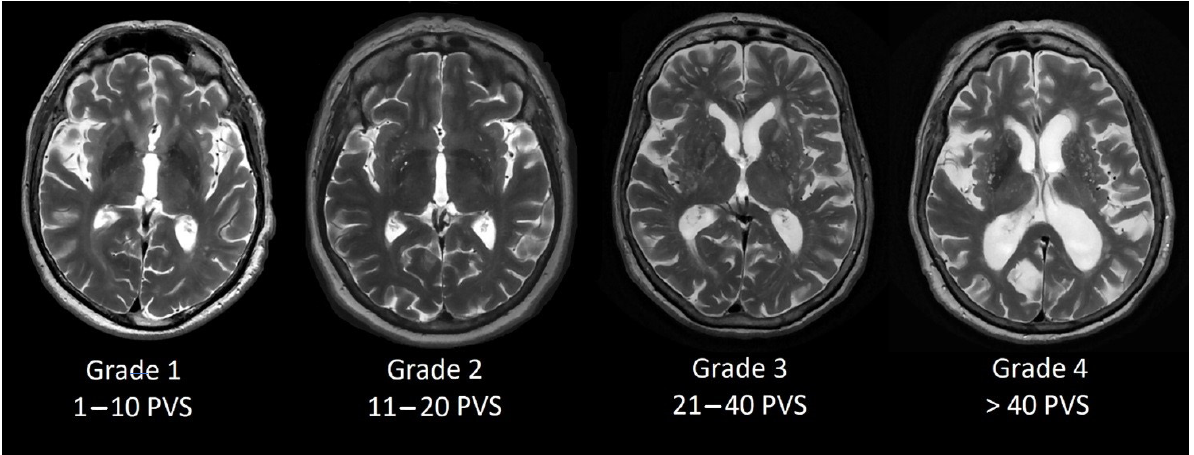
Figure 1. Dilated PVS in basal ganglia from Grade 1 to Grade 4.